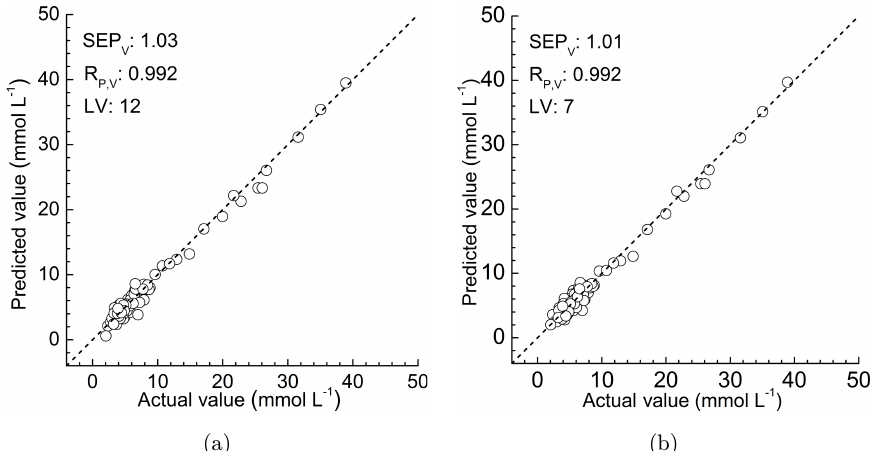
Fig. 6. Relationship between the predicted and actual SUN values based on the optimal models for (a) EC-PLS and (b)